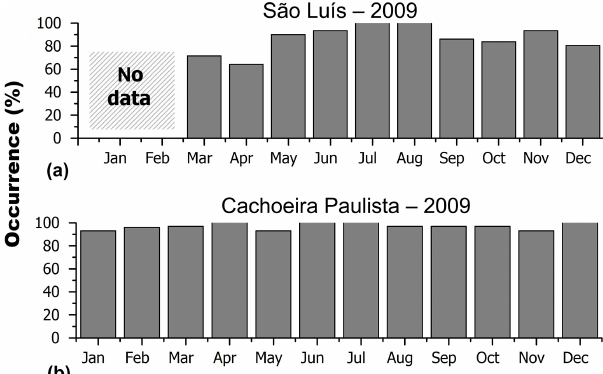
Figure 2. Monthly percentage occurrence of the descending inter- mediate layers for solar minimum period of 2009 at São Luís (a) and Cachoeira Paulista (b) . In (a) the lack of data during January and February is